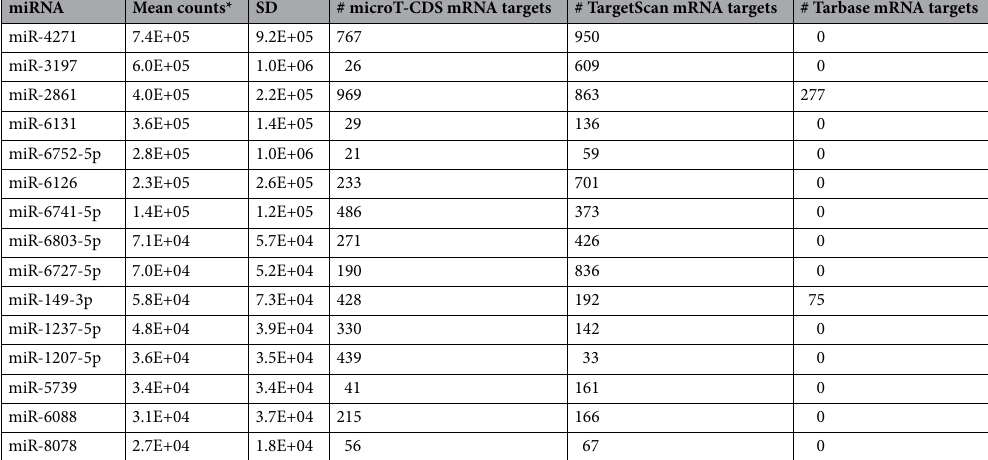
Table 4. Summary statistics for expression of top 15 human milk extracellular vesicle miRNAs. SD standard deviation. *Counts are median ratio normalized with DESeq2.